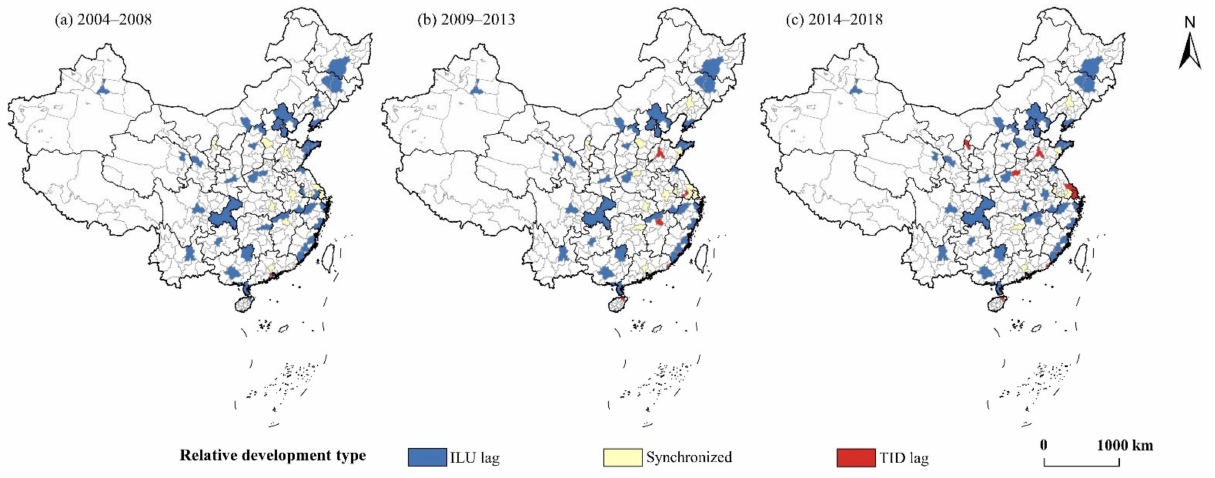
Figure 7. Variation in relative development types of ILU and TID from 2004 to